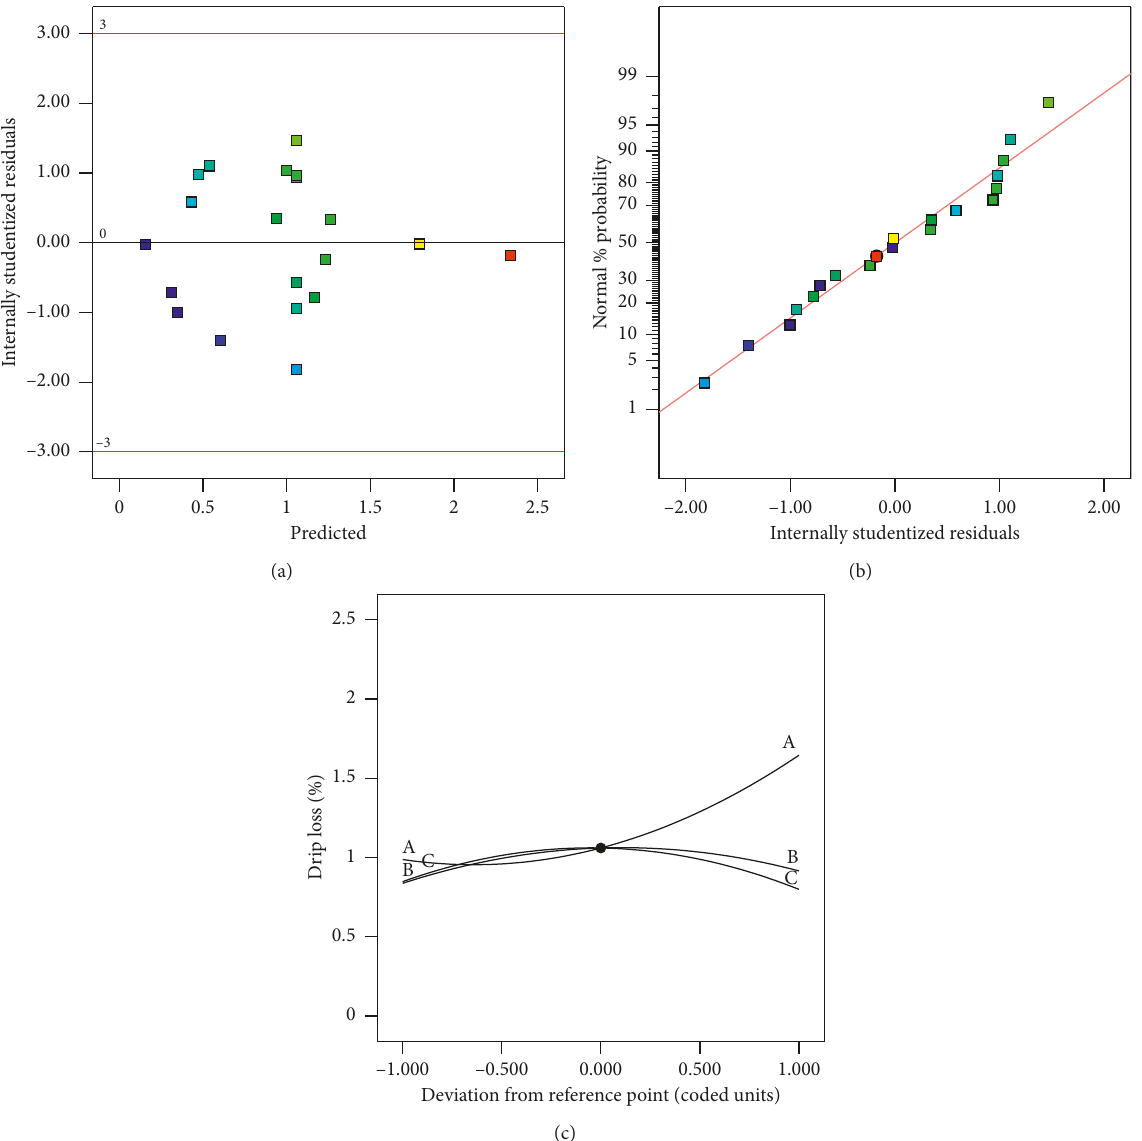
Figure 7: Response surface model diagnostic analysis of drip loss. (a) Internally studentized residuals of the predicted value; (b) Internally studentized residuals of the normal ploy; (c) Perturbation curve. Actual factors: (A) electrode distance � 10cm, (B) needle distance � 8cm, and (C) voltage �